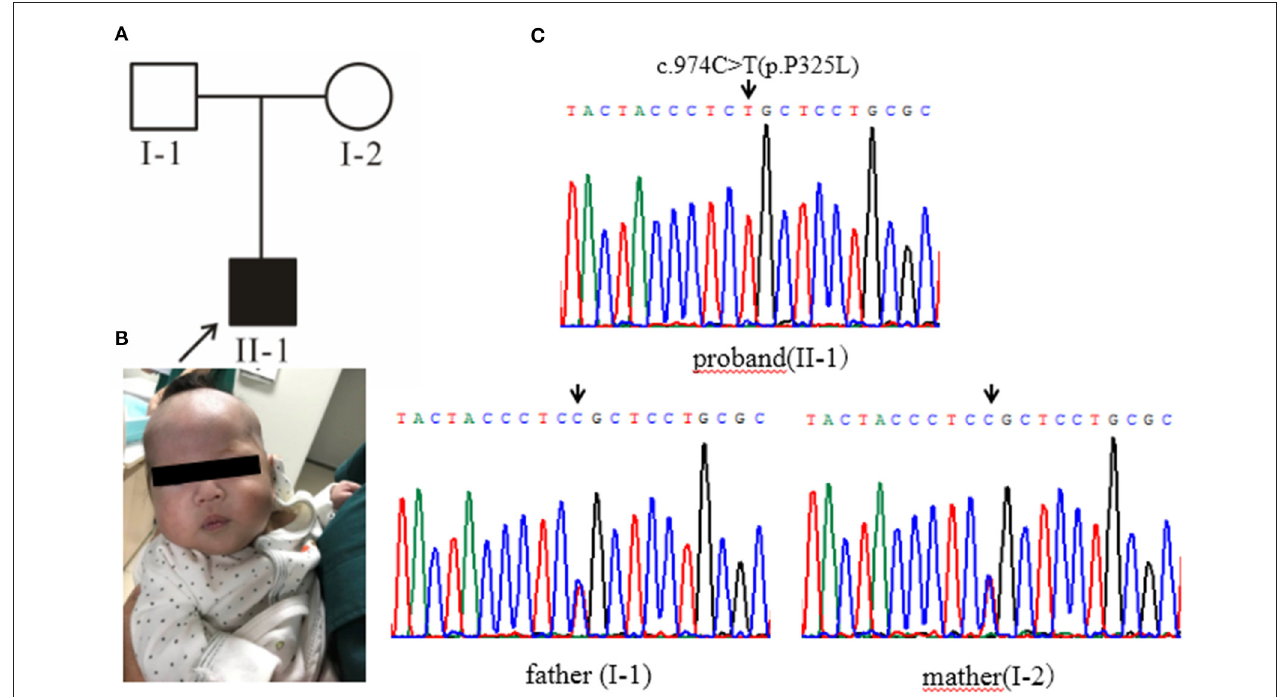
FIGURE 2 | (A) Pedigree chart, black arrow indicates the proband. (B) The proband’s condition improves after being fed milk powder without lactose. (C) Gene sequencing results: the proband of pedigree 2 carries the homozygous mutation of GALT gene c.974C > T (p.Pro325Leu) and the parents are all carriers of the